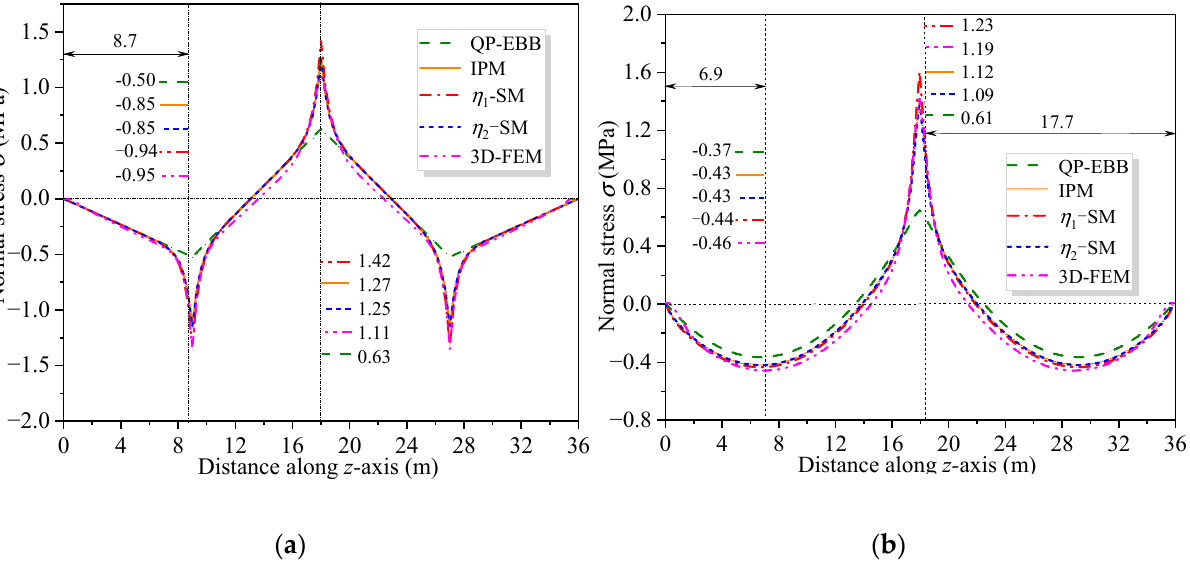
Figure 12. Vertical distribution of normal stress along the cross-section under load case 2: ( a ) cross-section 9.0 m away from the middle support; ( b ) cross-section 0.3 m away from the middle support.